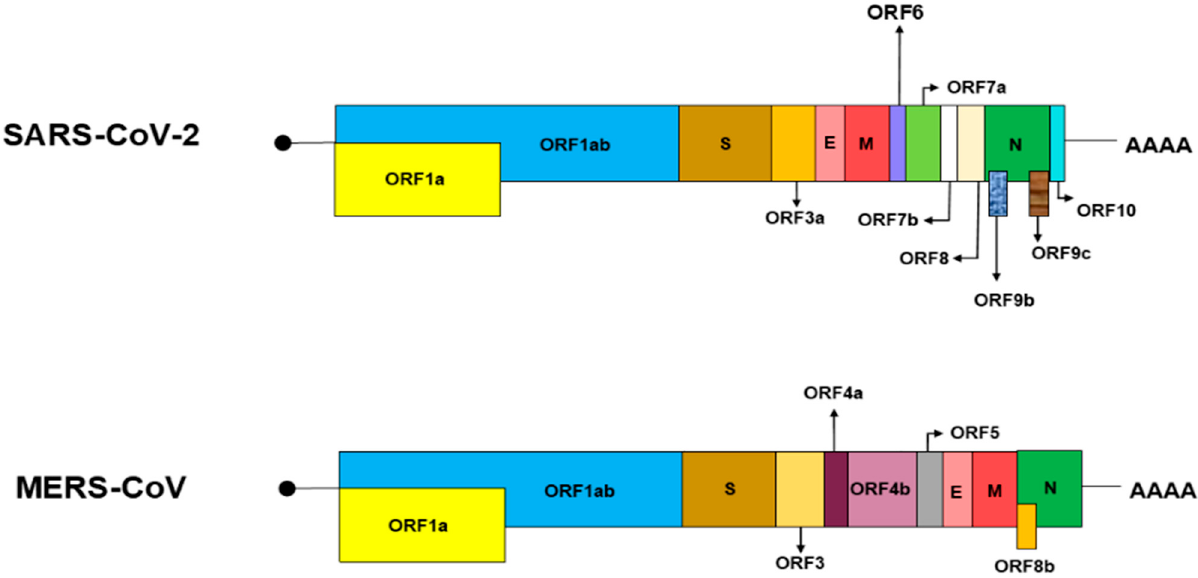
Figure 1. Structure of SARS-CoV-2 and MERS-CoV genomes.